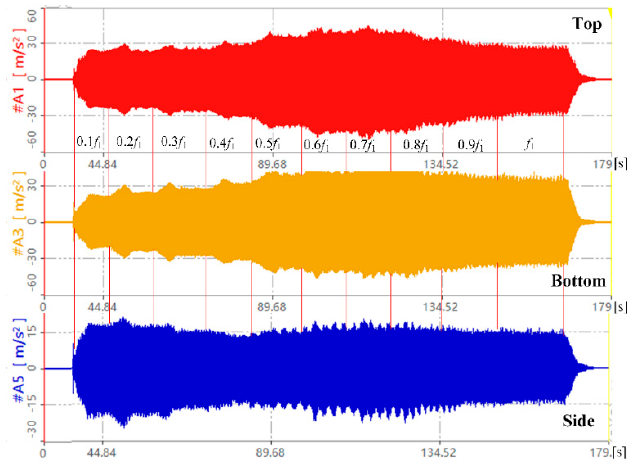
Figure 6. Vibration acceleration of three measuring points on the frame.